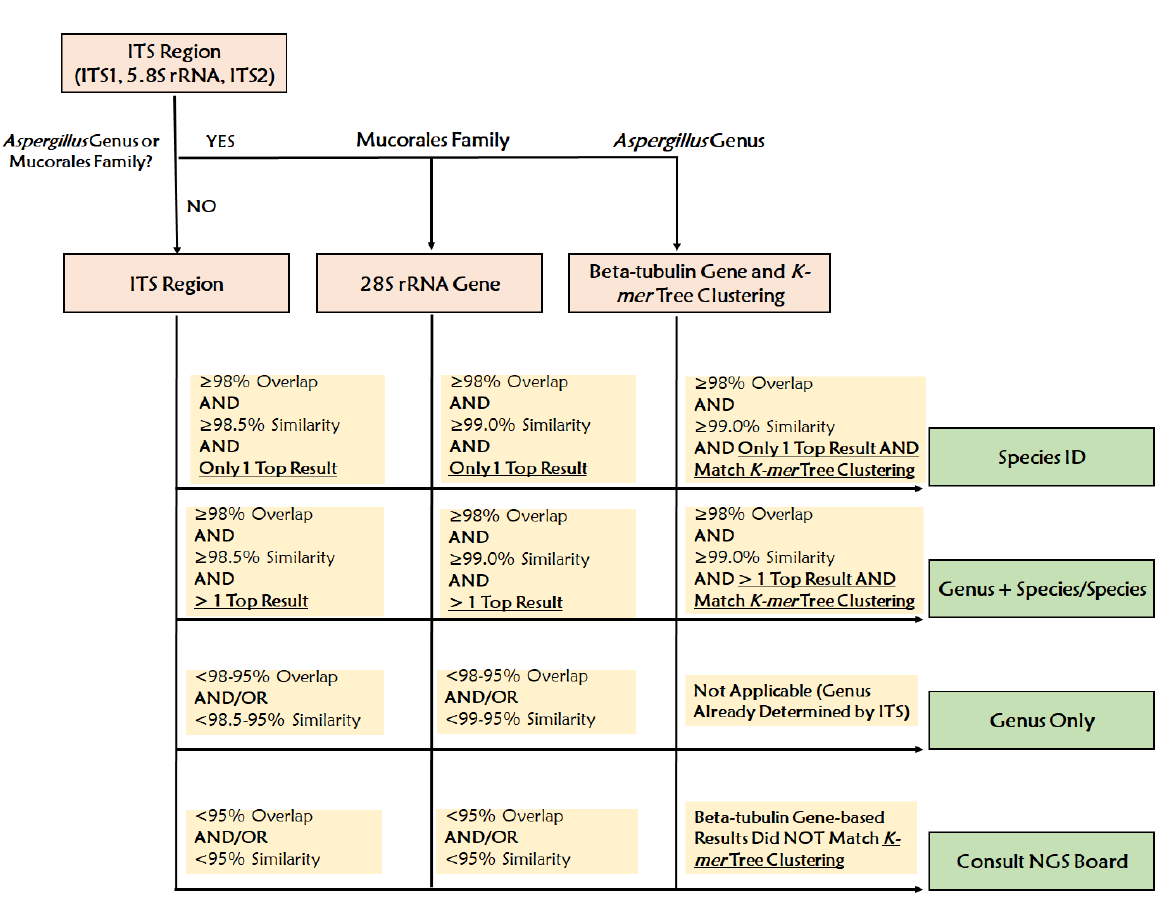
Figure 2. The Workflow of the WGS Test for Fungal Identification.